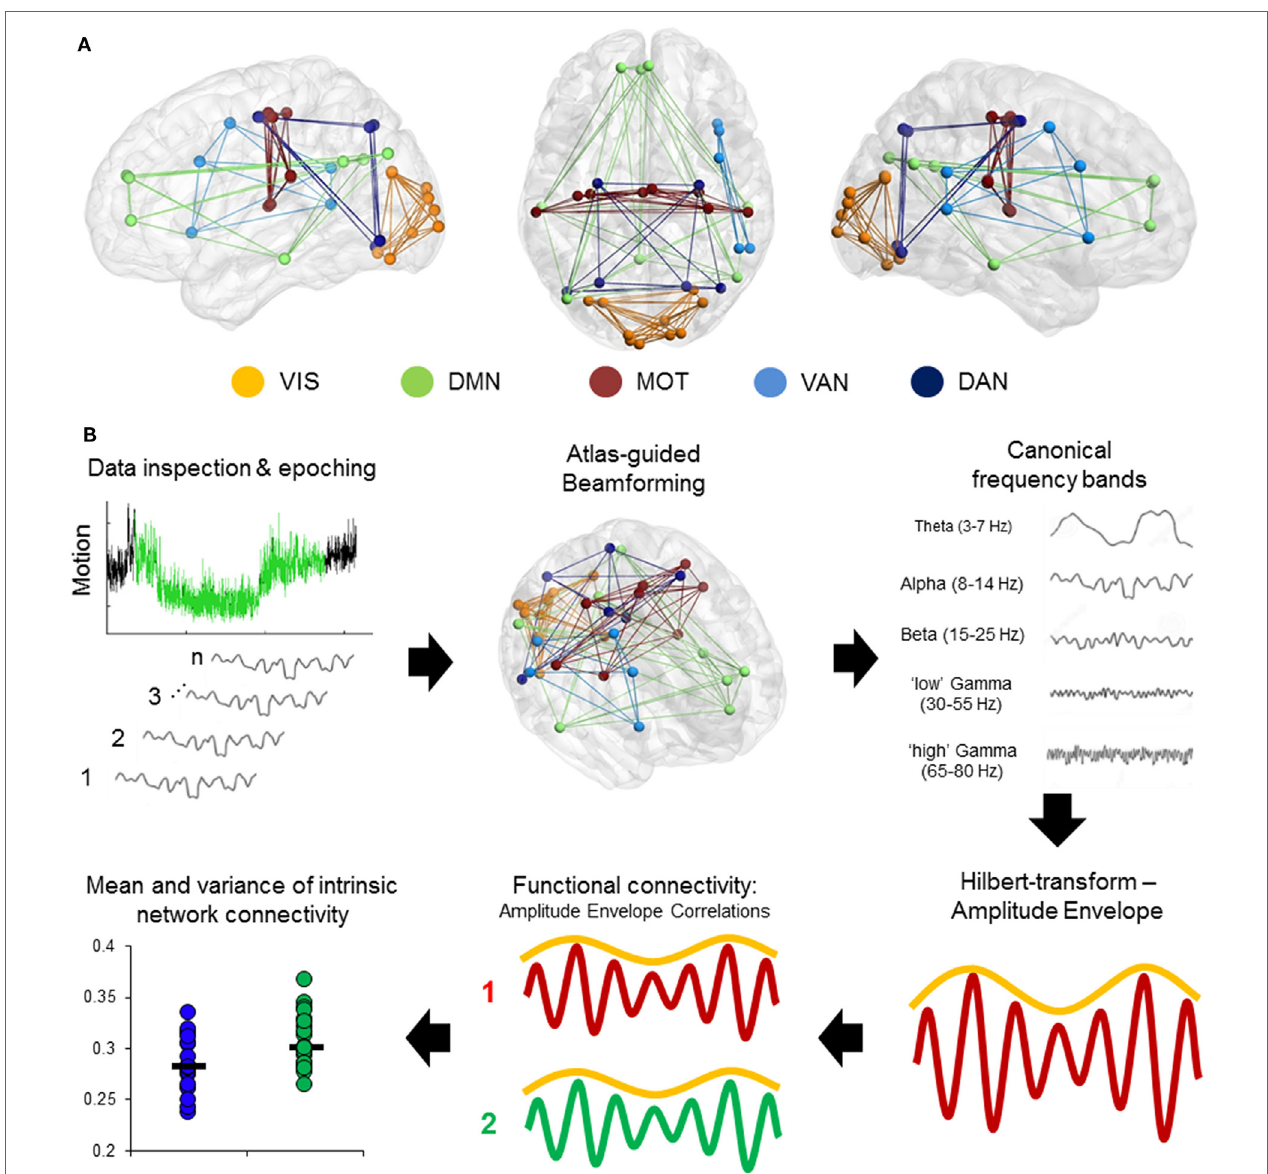
FigUre 1 | Computing intrinsic connectivity network (ICN) resting-state coupling. (a) Nodes and internal connections of the pre-defined ICNs seed regions based on Montreal Neurological Institute coordinates reported in the literature. (b) Analysis steps in the pipeline. Data were searched for 2 min of minimal head motion from the 5-min recording, and subsequently epoched into 12 s × 10 s segments. A vector beamformer was used to derive “virtual-sensor” time-series from all seeds and filtered into canonical frequency bands. A Hilbert transform was applied to derive estimates of the instantaneous amplitude envelope. Each pairwise combination of time-series amplitude envelopes inside a network were then correlated to define the degree of connectivity between nodes and averaged per epoch to derive a measure of internal connectivity. These were then both averaged over epochs and the SD